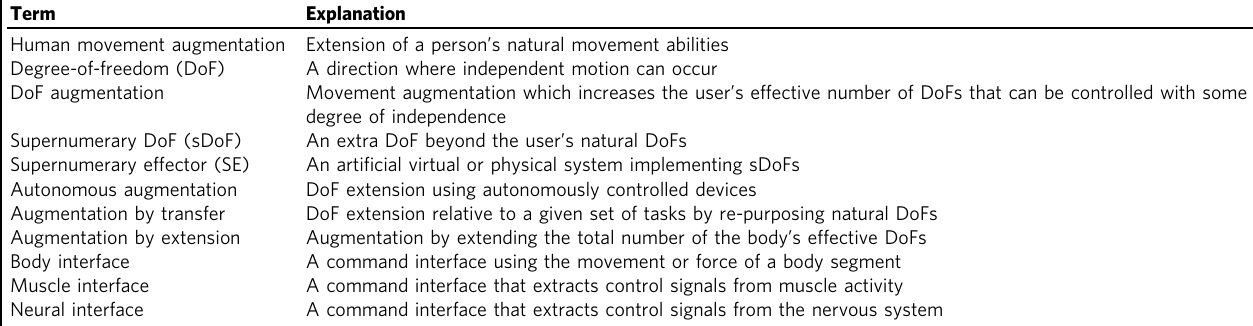
Table 1 Explanation of key terms used. Term